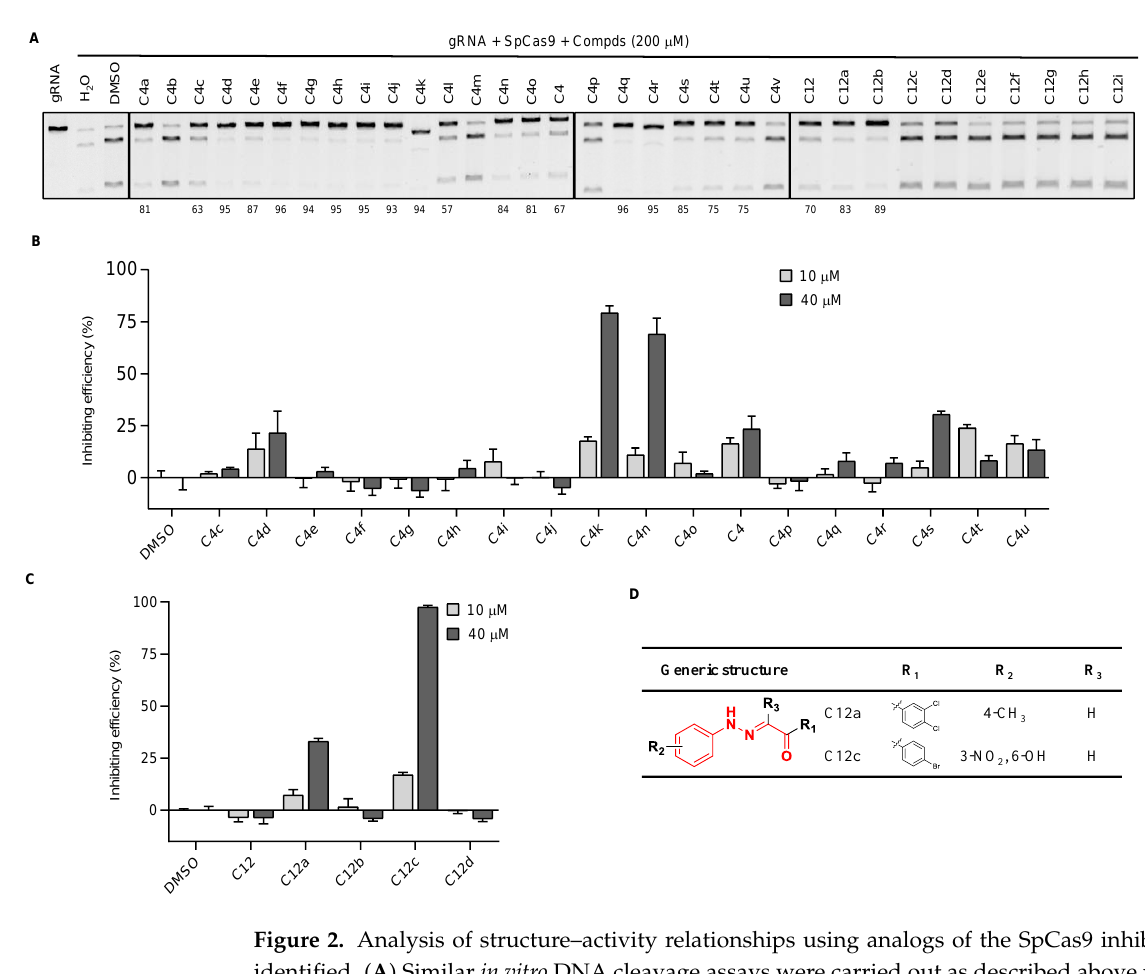
Figure 2. Analysis of structure–activity relationships using analogs of the SpCas9 inhibitors we identified. ( A ) Similar in vitro DNA cleavage assays were carried out as described above using the three groups of inhibitor analogs. The number indicates the compound ’ s inhibition rate. ( B , C ) Similar in cellulo assessment of the inhibitory activities of the compound analogs was carried out as described above using the reporter 293T cells. Error bars represent SD from three biological repeats. ( D ) The chemical structure of C12a and C12c.